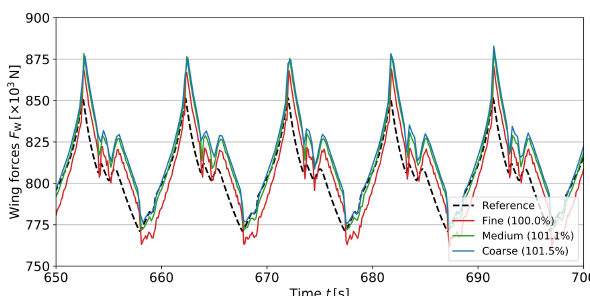
Figure A5. Time series of integrated wing forces acting on the drag- mode AWE system for three different grid resolutions. The black dashed lines show the OCP